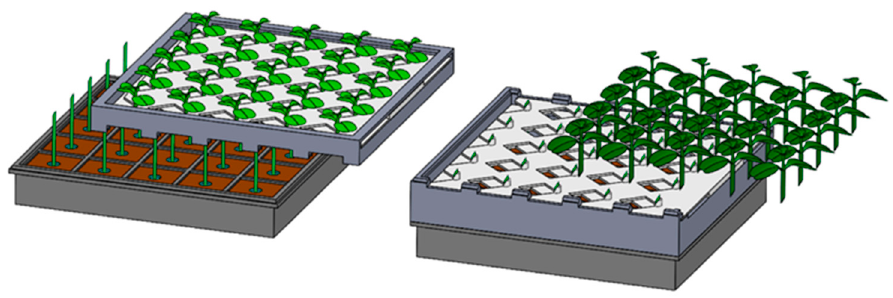
Figure 4. Clamping and positioning of rootstock and scion seedlings: 1. Scion seedling plug tray; 2. Scion clamping and positioning device; 3. Scion cutting blade; 4. Tool holder; 5. Rootstock seedling plug tray; 6. Rootstock clamping and positioning device; 7. Rootstock cutting blade.